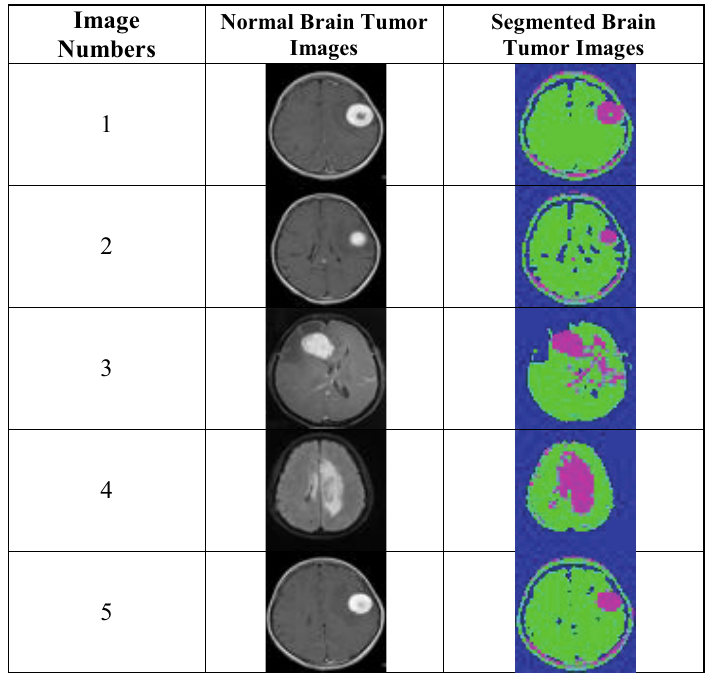
Table 1. Normal and Segmented Brain Tumor